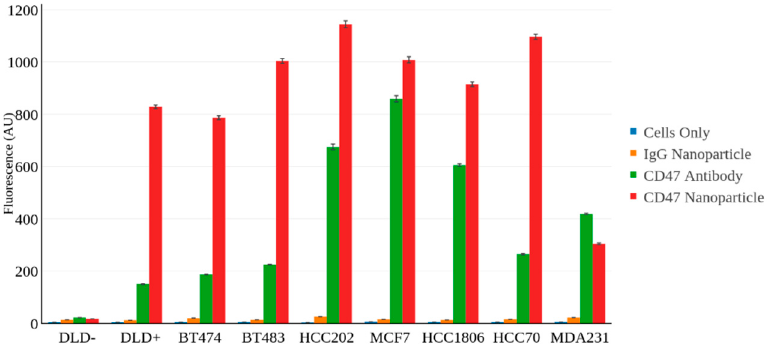
Figure 5. Quantitative FACS data comparing signal from cells only ( blue ), cells labeled with an isotype-NP ( orange ), cells labeled with anti-CD47 mAb ( green ), and cells labeled with CD47-NP ( red